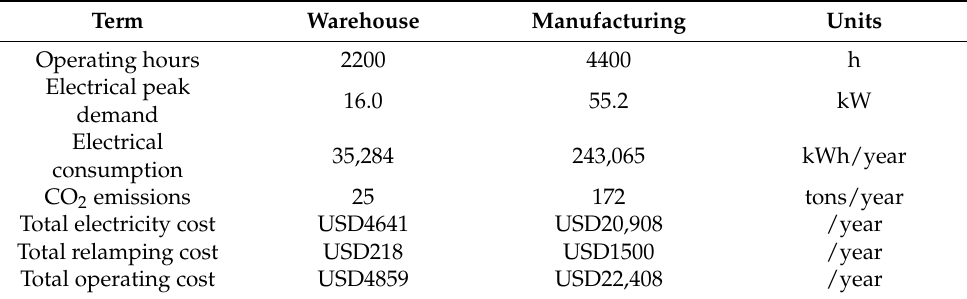
Table 2. Lighting fixture information before adding occupancy